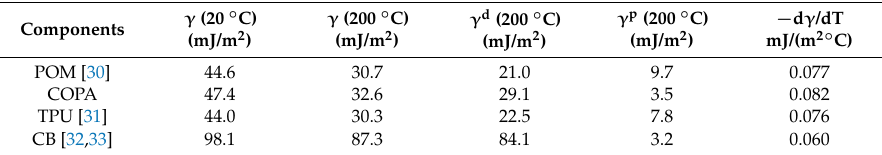
Table 1. Surface tension ( γ ) and the surface tension components ( γ d , γ p ) and (–d γ /dT) for polymers and CB at different